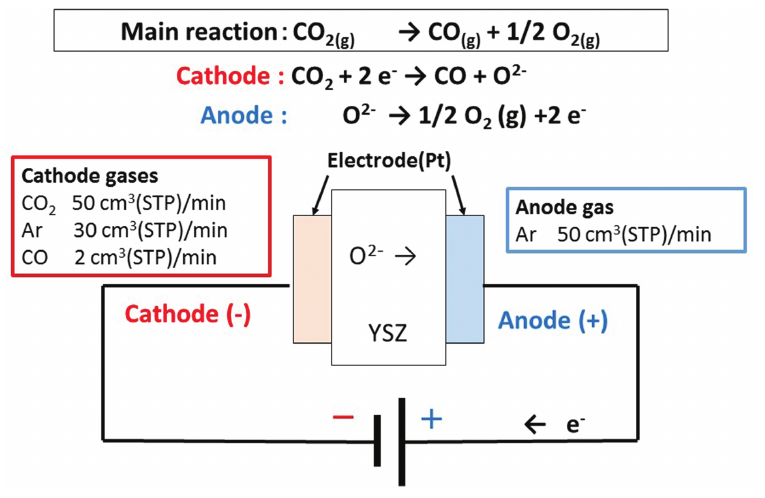
Figure 1: Reaction system used in the present study.